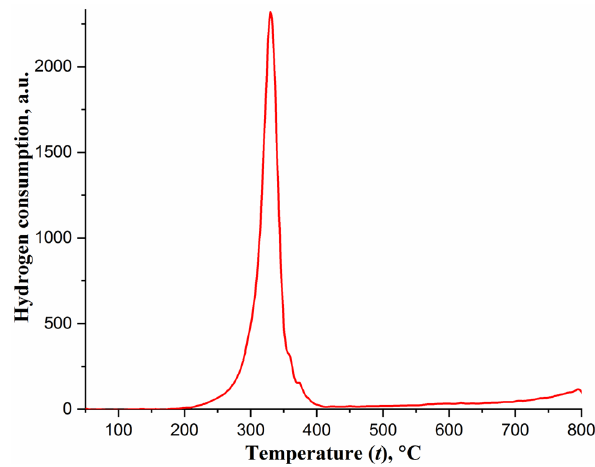
Figure 7: H 2 -TPR profile of CuO/CeO 2 -urea